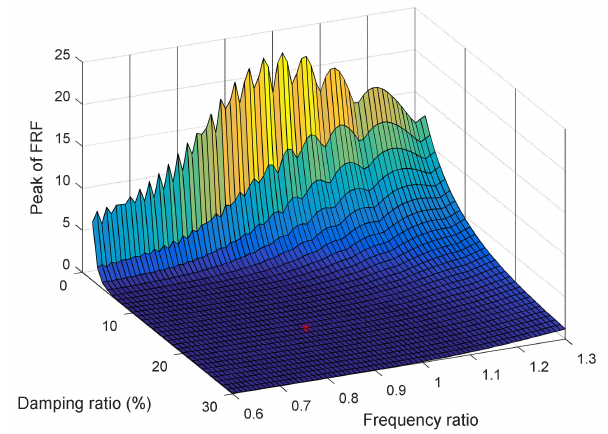
Figure 9. FRF peak surface depending on TMD